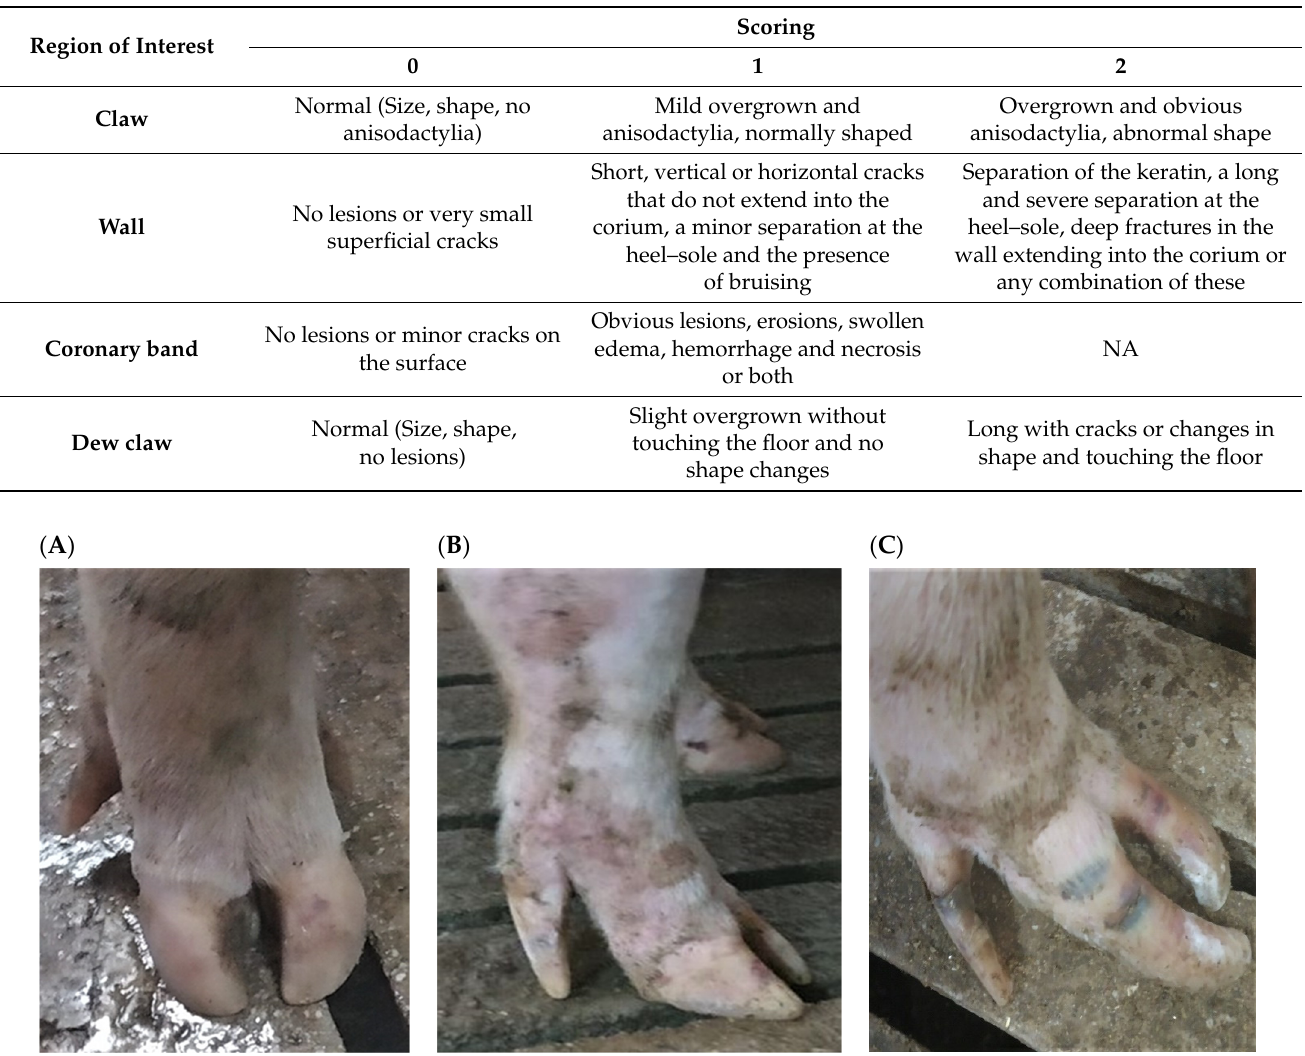
Figure 2. Examples of lesion scoring in sows of different genetic lines in three farrow-to-finish